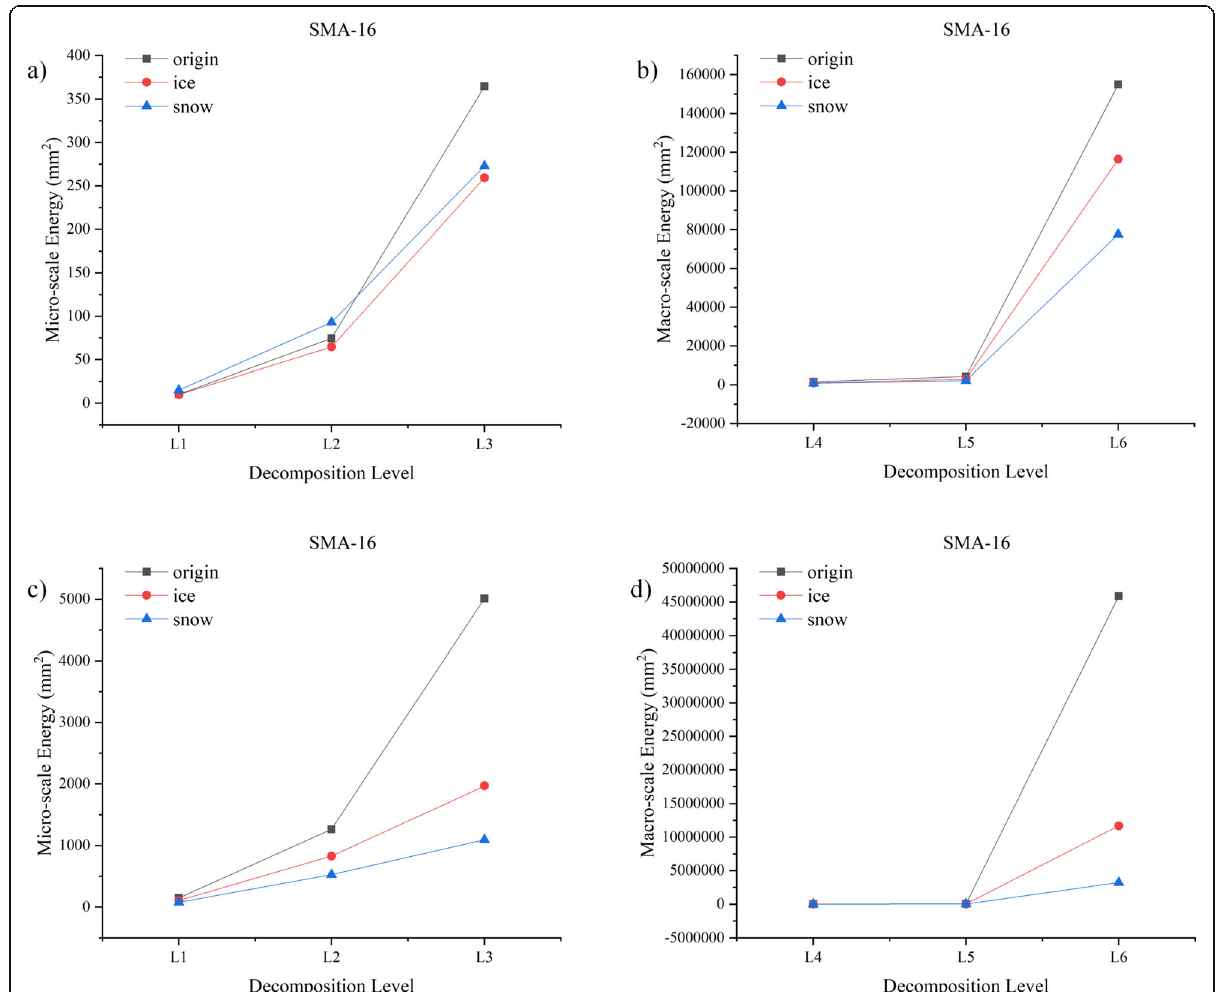
Fig. 11 The Energy Results of SMA-16; a 50% Cutting Plane in micro-scale, b 50% Cutting Plane in macro-scale, c 100% Cutting Plane in micro- scale, d 100% Cutting Plane in